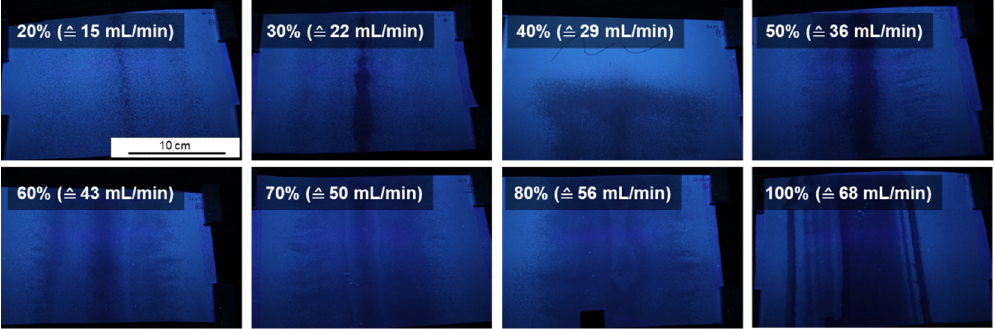
Figure 10. Spray cast membranes of PS 83 - b -P4VP 1788k at different pulsing rates R under UV-light after casting and drying (25SS).